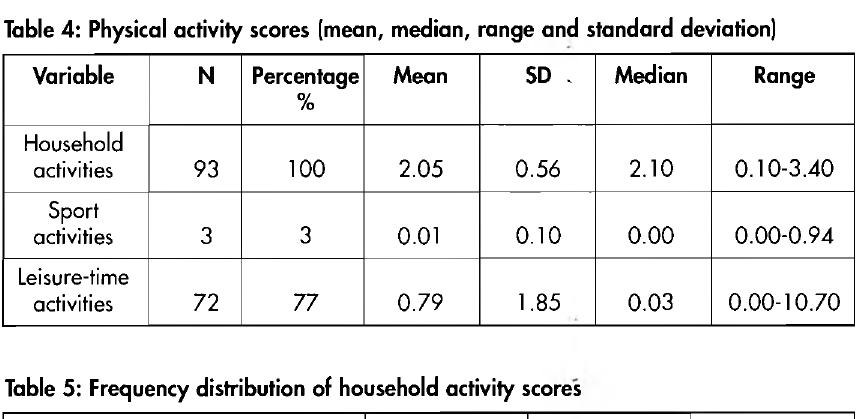
Table 5: Frequency distribution of household activity scores